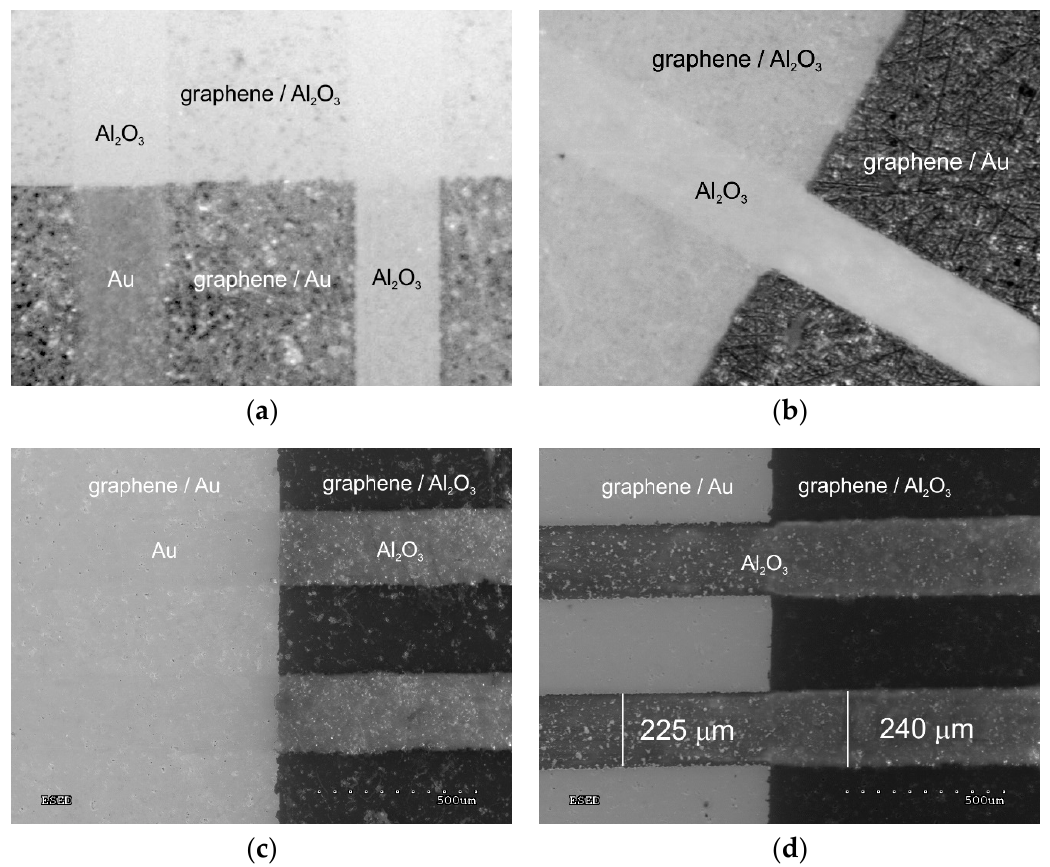
Figure 5. Microscopic pictures of graphene structures (paths) shaped by laser ablation: ( a , b ) optical microscopy and ( c , d ) SEM.